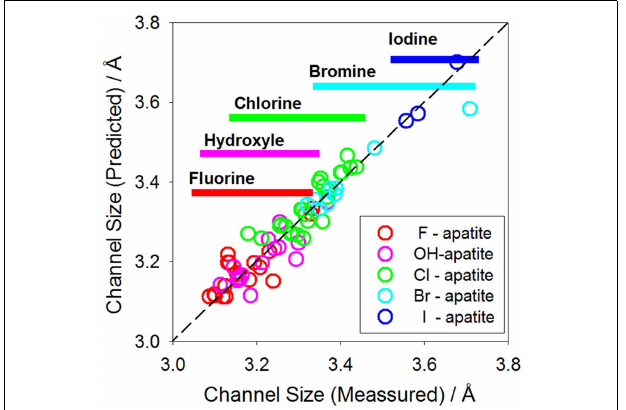
FIGURE 6 | Correlation between the channel size and ionic radius of the channel anion. The open circles are actual experimental data. The horizontal bars correspond to the range of channel size of experimental determined crystal structures. The dashed line corresponds to when predicted and actual values are equal.